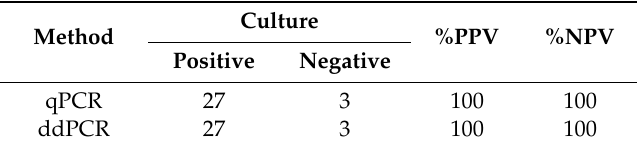
Table 2. Comparison of ddPCR and qPCR in detection of real isolates. Positive predictive value